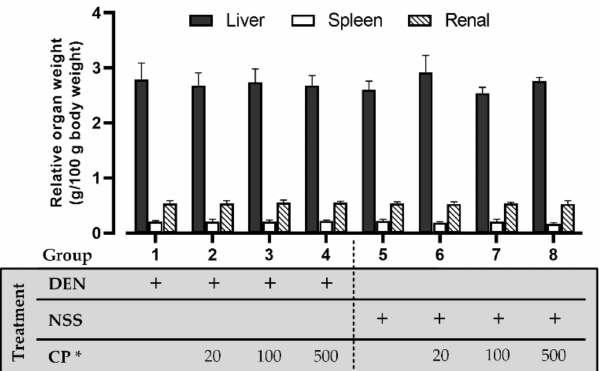
Figure 1. The effect of CP on relative vital organ weight. DEN or NSS were initially administered at week 0 and 1. Then either DW (for groups 1 and 5) or CP were fed weekly starting from week 2 till the end of the experiment. Data was distributed normally (Shapiro-Wilk and Levene’s test: p ≥ 0.05) and was analyzed for statistically significance using one-way ANOVA with LSD’s post hoc test: F (Liver) = 1.577 ( p = 0.159), F (Spleen) = 1.992 ( p = 0.070), and F (Renal) = 0.549 ( p = 0.794). * CP dosage unit; mg/kg BW.